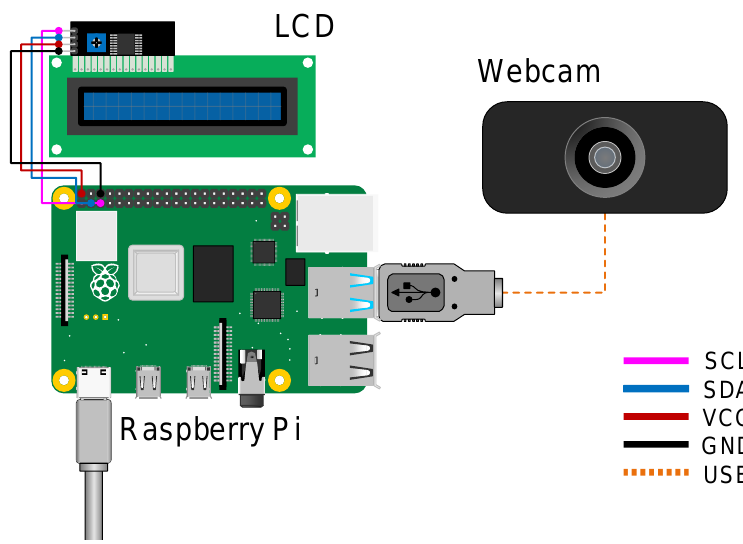
Figure 8. Design block diagram.